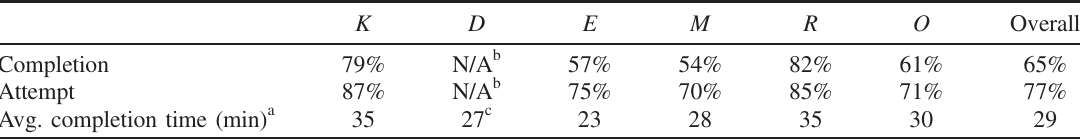
TABLE II. Student usage of the coaches by course topic in fall 2011. K is kinematics, D is dynamics, E is energy, M is momentum, R is rotations including statics, and O is oscillations. The overall figures exclude the dynamics coaches. The data come from the student keystrokes recorded in the